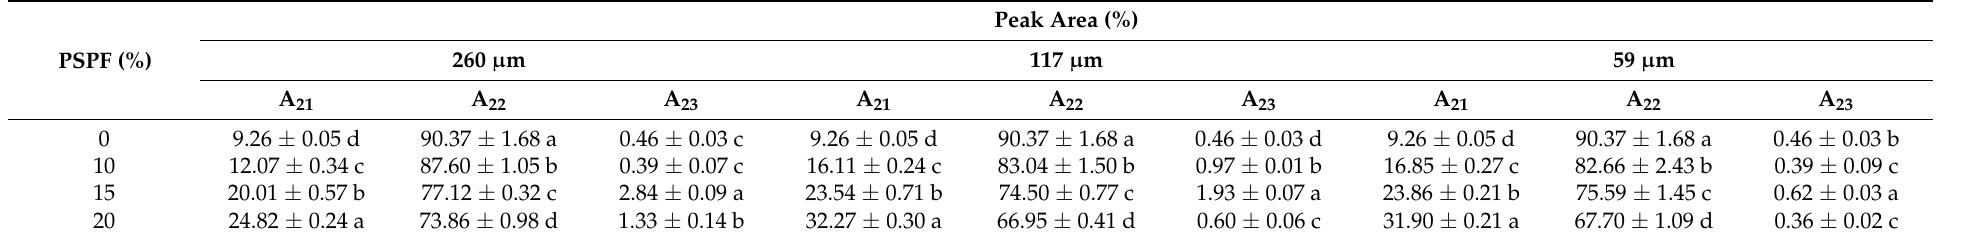
Table 6. Fractions of signal amplitude of protons of formulated flour doughs influenced by different particle size distributions and addition levels detected by low-field 1 H